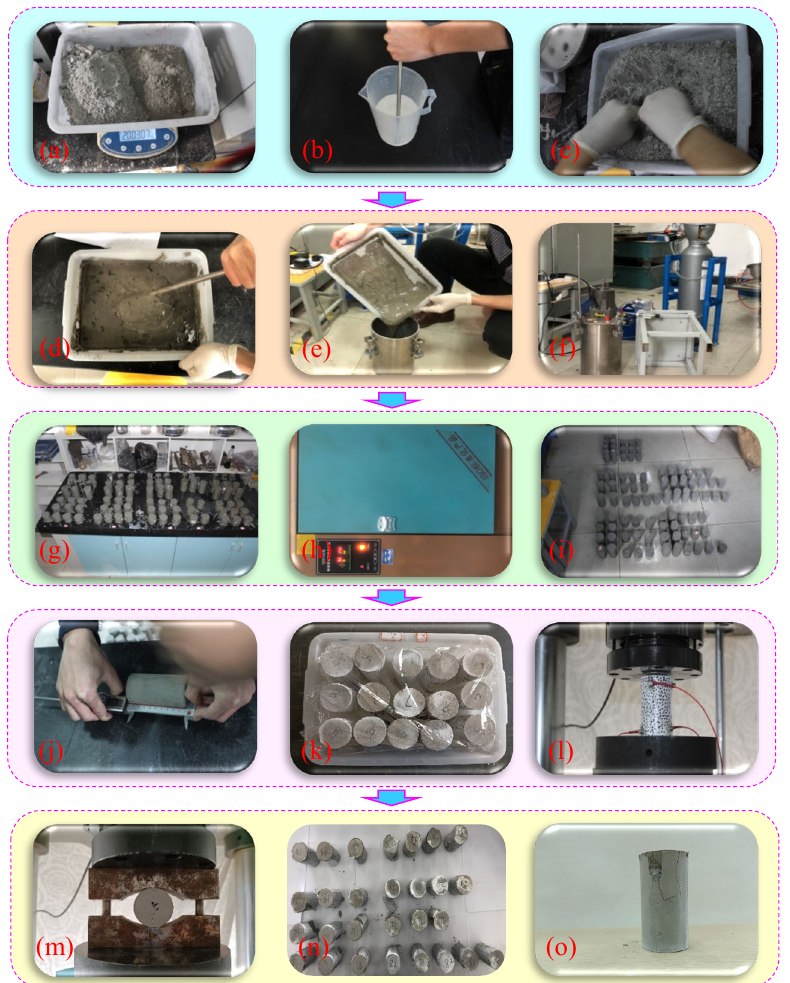
Figure 3. The process of preparing the CMFB specimens and the mechanical tests. ( a–c ): weighing and mixing of aggregate and auxiliary materials ( d–f ): development of fresh slurry of CMFB. ( g–o ): dimension calibration and mechanical test of CMFB samples.